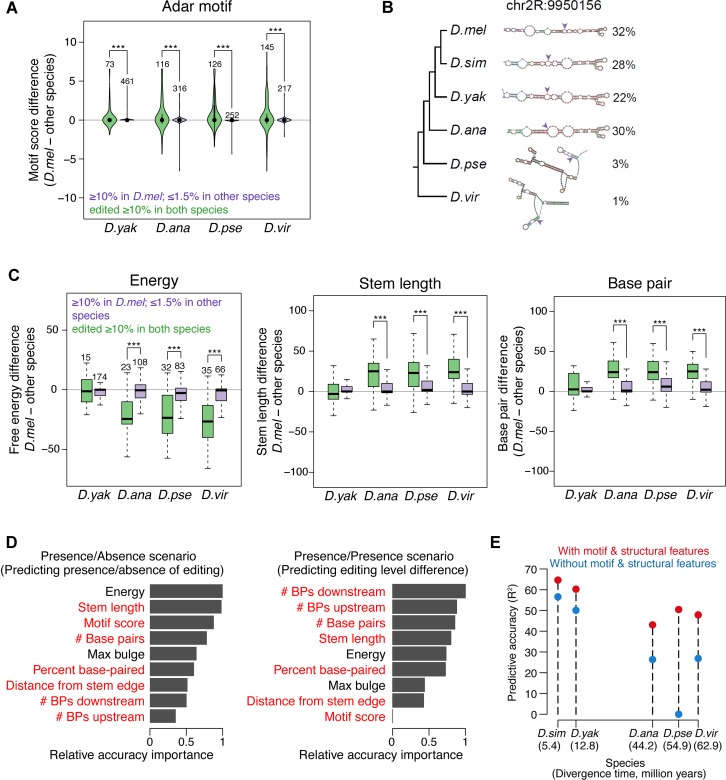
Cis regulatory features explain and predict the divergence of RNA editing levels.(A) The difference in ADAR binding motif scores between sites that are edited (≥10%) in D.mel but not edited (≤1.5%) in other species (green) compared to the difference in sites that are edited (≥10%) in both species (purple). *: p ≤ 0.05, **: p ≤ 0.01, ***: p ≤ 0.001 (one-tailed Mann-Whitney U test) (B) An example of the relationship between structure and editing level changes across species. The editing site is indicated by the purple arrows. (C) The difference in free energy, stem length, and paired bases between sites that are edited (≥10%) in D.mel but not edited (≤1.5%) in other species and control sites that are edited (≥10%) in both species. The numbers of editing sites are indicated above the bars. *: p ≤ 0.05, **: p ≤ 0.01, ***: p ≤ 0.001 (one-tailed Mann-Whitney U test) (D) Relative importance of ADAR motif and dsRNA structural features to predict the establishment of editing (left) and the variation in editing levels (right). In the Presence/Absence editing scenario (left), given that a site was edited (≥10%) in one species, we predicted whether sites were edited (≥10%) or not edited (≤1.5%) in another species. In the Presence/Presence editing scenario (right), given the editing level in one species, we predicted the editing level in another species, requiring that the sites were edited (≥10%) in both species. The D.mel—D.vir comparison is shown. Features with positive and negative relationships with presence of editing (left) or increase of editing level (right) are marked in red and black, respectively. (E) Comparison of predictive accuracy of editing levels of two models (with or without motif and structural features). Given the editing levels in D.mel, editing levels in each of the other species were predicted using the random forests model. Sites with editing level ≥10% in at least one of the paired species were included in the analysis.